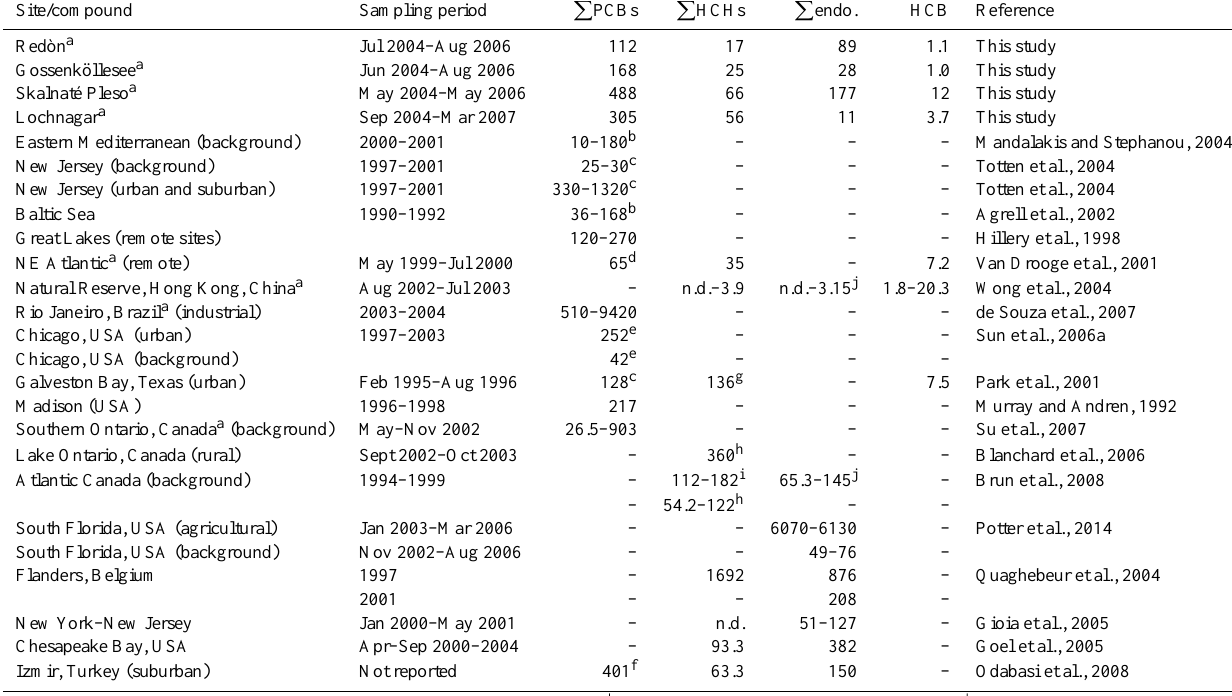
Table 3. Comparison of mean deposition fluxes of OC measured in remote European mountain regions with those reported in the literature.